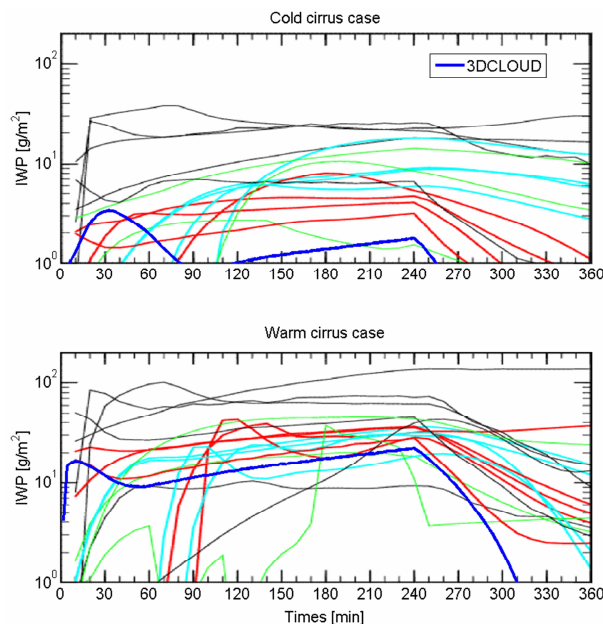
Figure 6. Time series of vertically integrated ice water path (IWP) from different cirrus models, which participated in the Idealized Cirrus Model Comparison Project and from the 3DCLOUD model (thick blue lines). The upper panel is for the cold cirrus case and the bottom one is for the warm cirrus case. Cyan line represents models with bin microphysics, red line models with bulk microphysics, green line single column models, and thin black lines models with heritage in the study of deep convection or boundary layer clouds. This figure is made from the one taken from Starr et al. (2000) and Yang et al. (2012).